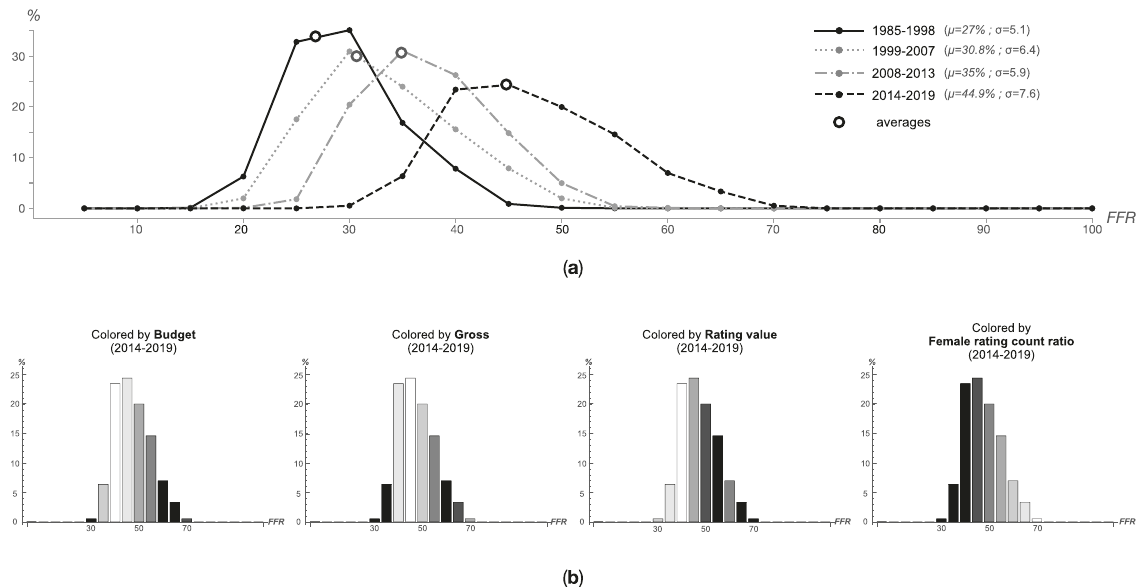
Fig. 4 Distributions of female face ratio ( FFR ). a Distributions of FFR for each period: Percentage of movies with a given FFR , one data point every 5%. b Distributions of several features over the distribution of FFR : Percentage of movies with a given FFR , colored by the given variable mean within the bin, the lighter the